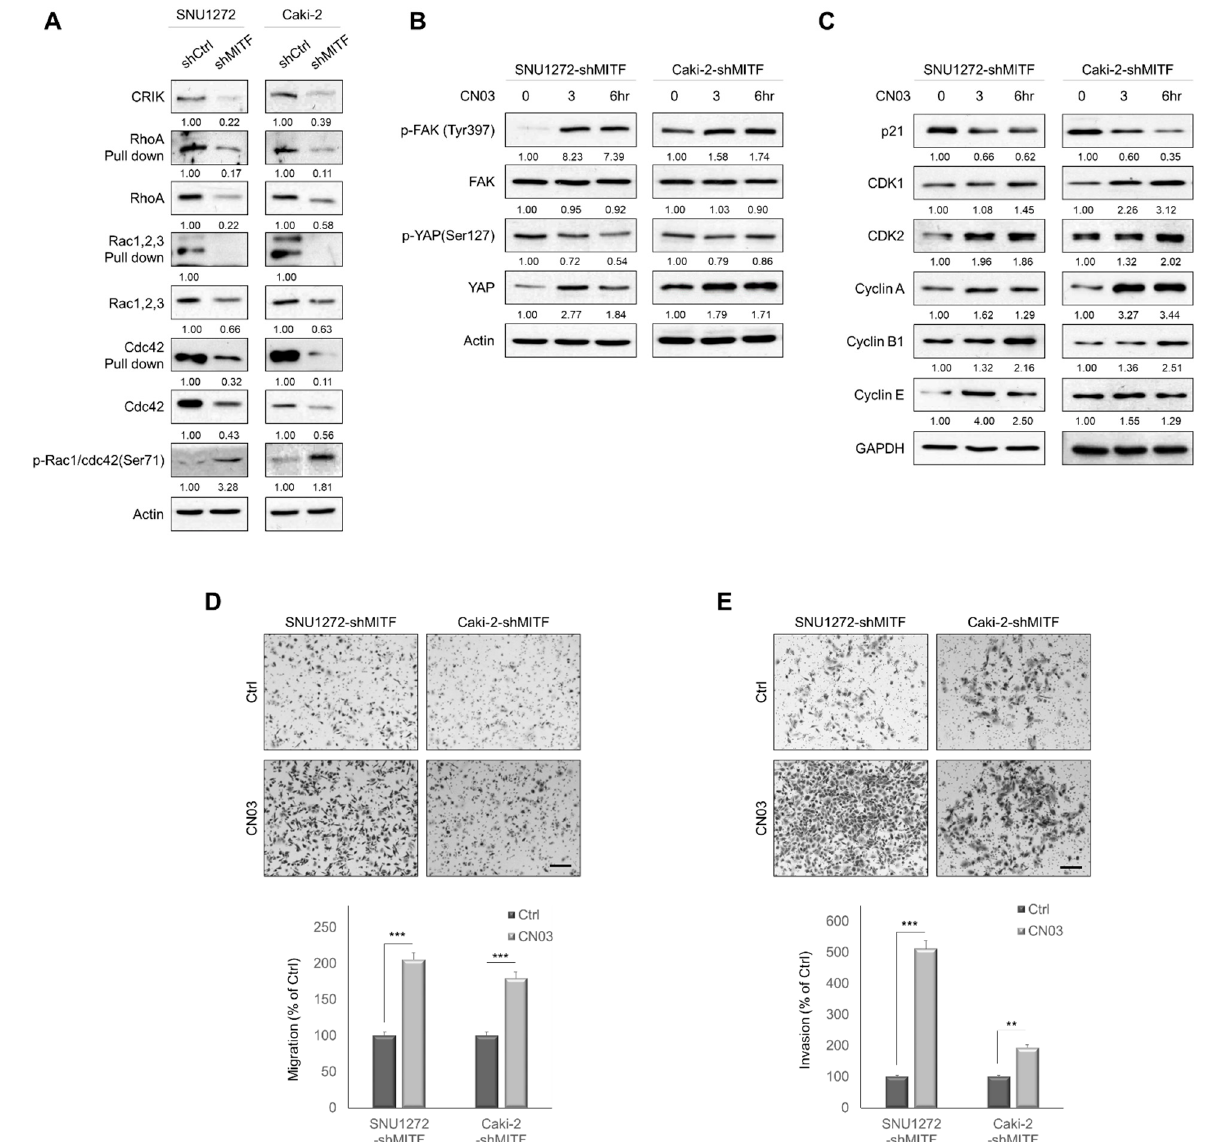
Figure 4. MITF knockdown suppresses RhoA activation. ( A ) Pull-down assay of Rho family proteins shows that knockdown of MITF inhibited activation of RhoA, Rac1–3 and Cdc42. Whole areas were measured using Image J software ( n = 3). Uncropped blots are shown in Figure S7. ( B ) MITF-knockdown cells were treated with 1 µ g/mL of CN03 for 3 or 6 h. Western blot analysis showed that CN03 effectively increased the expression of phospho-FAK and YAP. Whole areas were measured using Image J software ( n = 3). Uncropped blots are shown in Figure S7. ( C ) Western blot analysis showing expression of cell cycle-related proteins. Whole areas were measured using Image J software ( n = 3). Uncropped blots are shown in Figure S7. ( D , E ) Transwell migration and invasion assay showing that CN03 promoted MITF knockdown-induced cell migration and invasion. The number of cells in five randomly chosen fields was counted. Data are presented as the means ± standard deviation and were evaluated using Student’s t -test ( n = 3). Scale bar, 200 µ m. **, p < 0.01; ***, p <